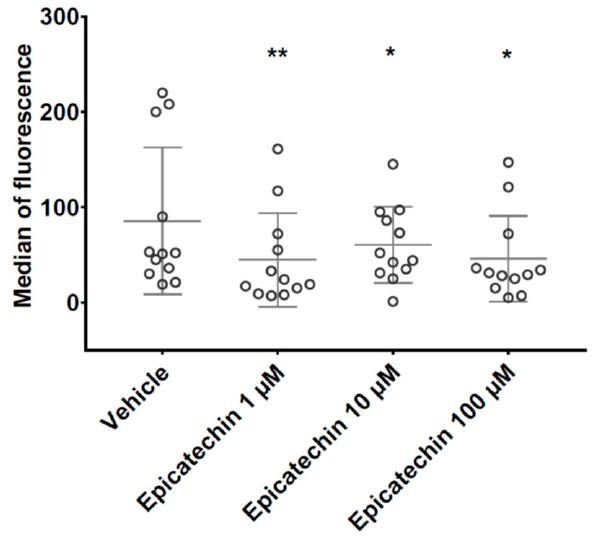
Figure 2. Impact of epicatechin on glycoprotein Ib expression at the surface of small PMPs. *, ** Significant effect of intensity.